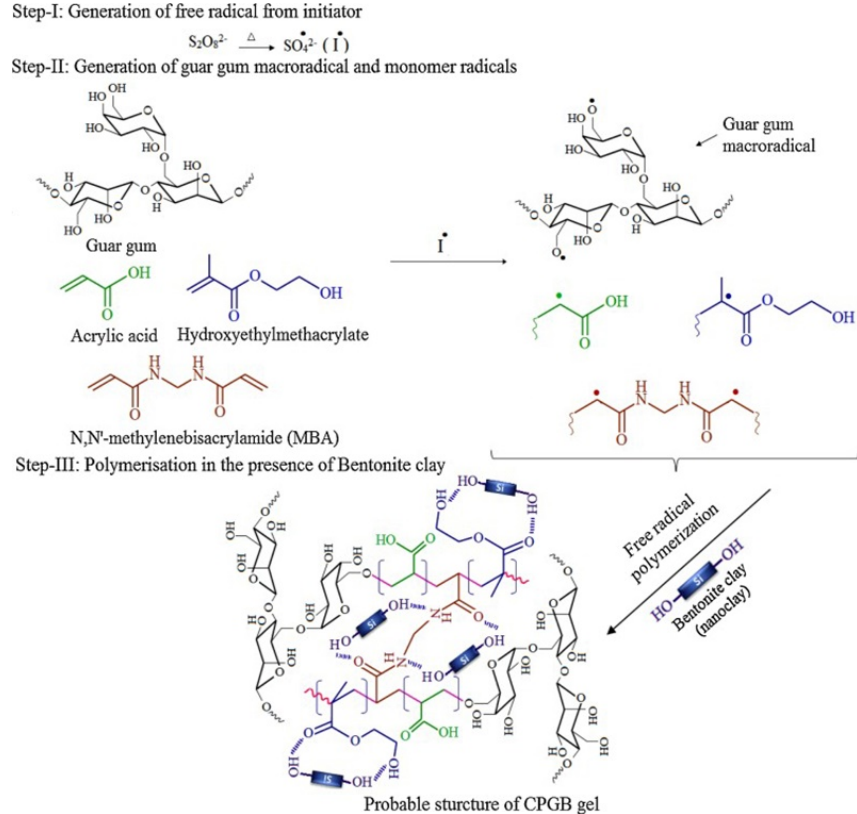
Figure 1. Formation process of guar gum-grafted polymer composite hydrogel [68] .